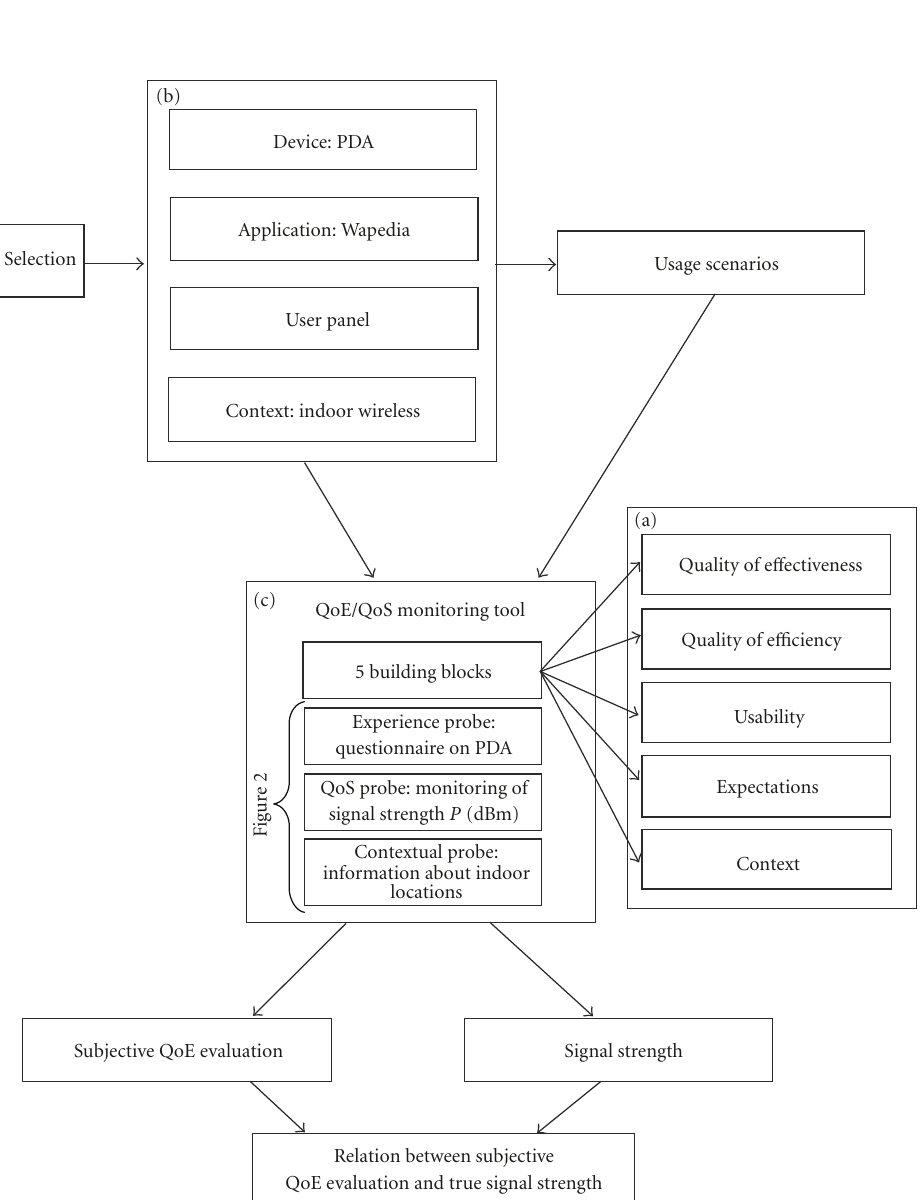
Figure 3: Flow graph of the following